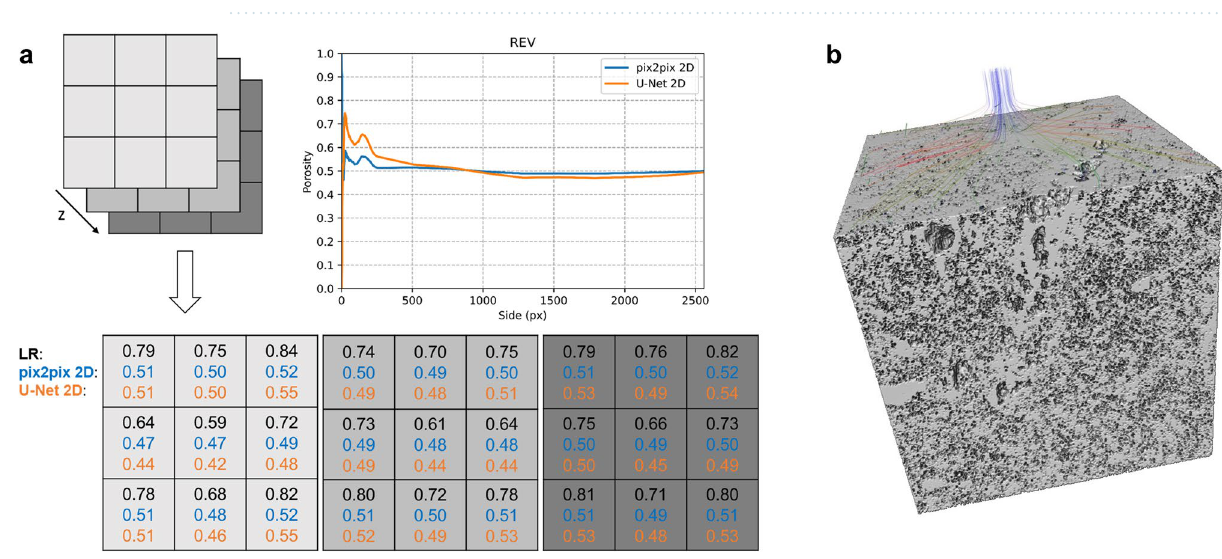
Figure 5. Super-resolved large tuff core: best models. Super-resolved images (2560 3 px) obtained applying the best trained networks, 2D pix2pix and U-Net trained on paired data, to a large unseen LR image (central 640 3 px; i.e., dominantly external to the training/validation dataset). LR images (input) are also shown for comparison. Slices from top, middle and bottom of the whole 3D images are presented, together with a zoom in their central portion in order to better detect the reconstructed microstructures.